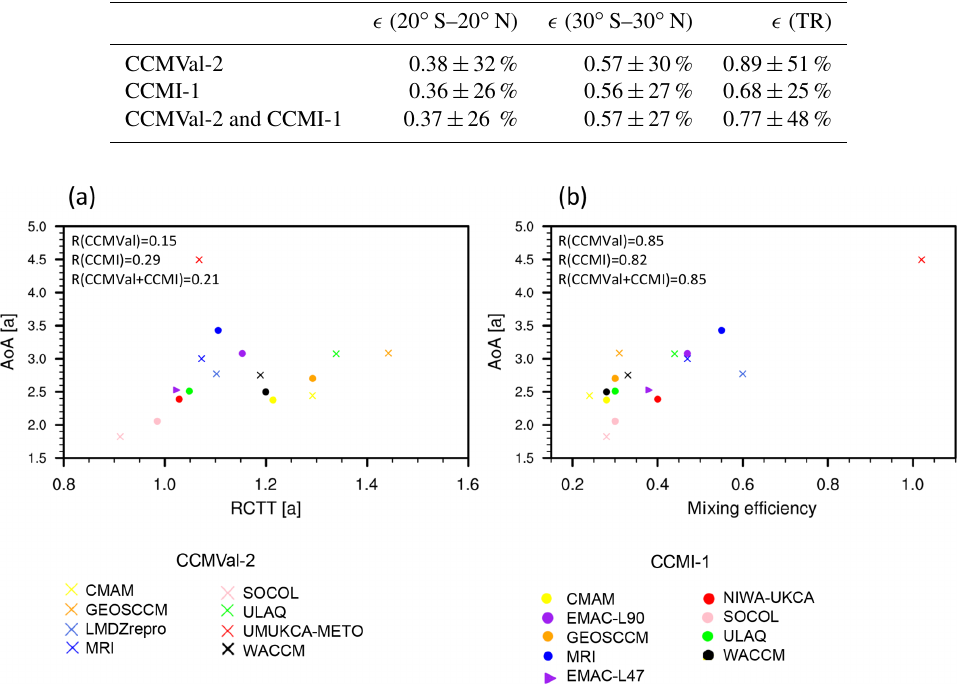
Table 3. CCMVal-2 REF-B1 and the CCMI-1 REF-C1 multi-model mean of mixing efficiency (cid:15) and its 1 σ inter-model standard deviation (in %). (cid:15) is derived by the TLP model, using three different tropical pipe definitions: 20 ◦ S–20 ◦ N, 30 ◦ S–30 ◦ N, and turnaround latitudes (TR). Note that the multi-model means of (cid:15) exclude the models UMUKCA-METO (CCMVal-2). (cid:15) (20 ◦ S–20 ◦ N)